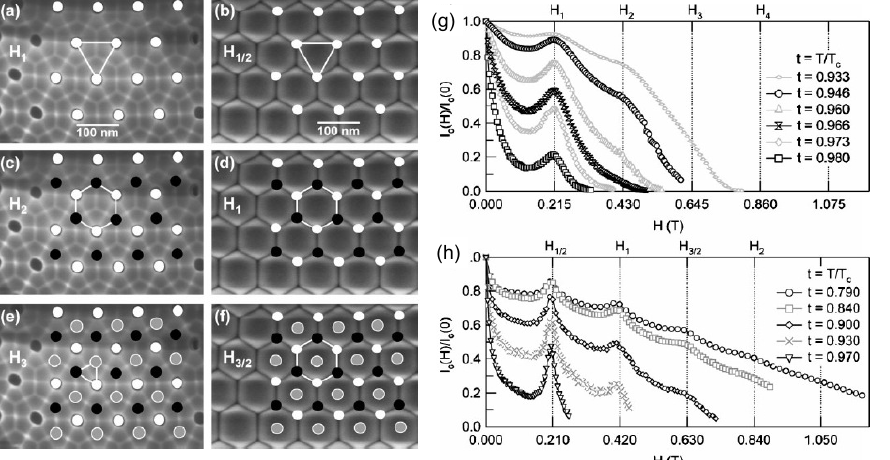
Figure 11. Vortex patterns for a 50-nm thick Nb film with a triangular lattice of antidots of ∼ 100-nm = 215 mT, ( c ) H top = 430 mT, and ( e ) H top = 645 mT, and the 50-nm thick sample spacing at ( a ) H top 1 1 1 = 210 mT, ( d ) H bottom = 420 mT, evaporated under 30 ◦ on the barrier layer surface at ( b ) H bottom 1/2 1/2 = 630 mT. Normalized critical-current curves versus magnetic field for different and ( f ) H bottom 1/2 reduced temperatures of ( g ) a 50-nm Nb film with triangular lattice of antidots (evaporated perpen- dicularly onto the top surface) and ( h ) a 50-nm Nb film with a quasi-hexagonal thickness modulation (evaporated under 30 ◦ from normal onto the bottom surface). Reprinted with permission from Ref. [49]. Copyright 2009